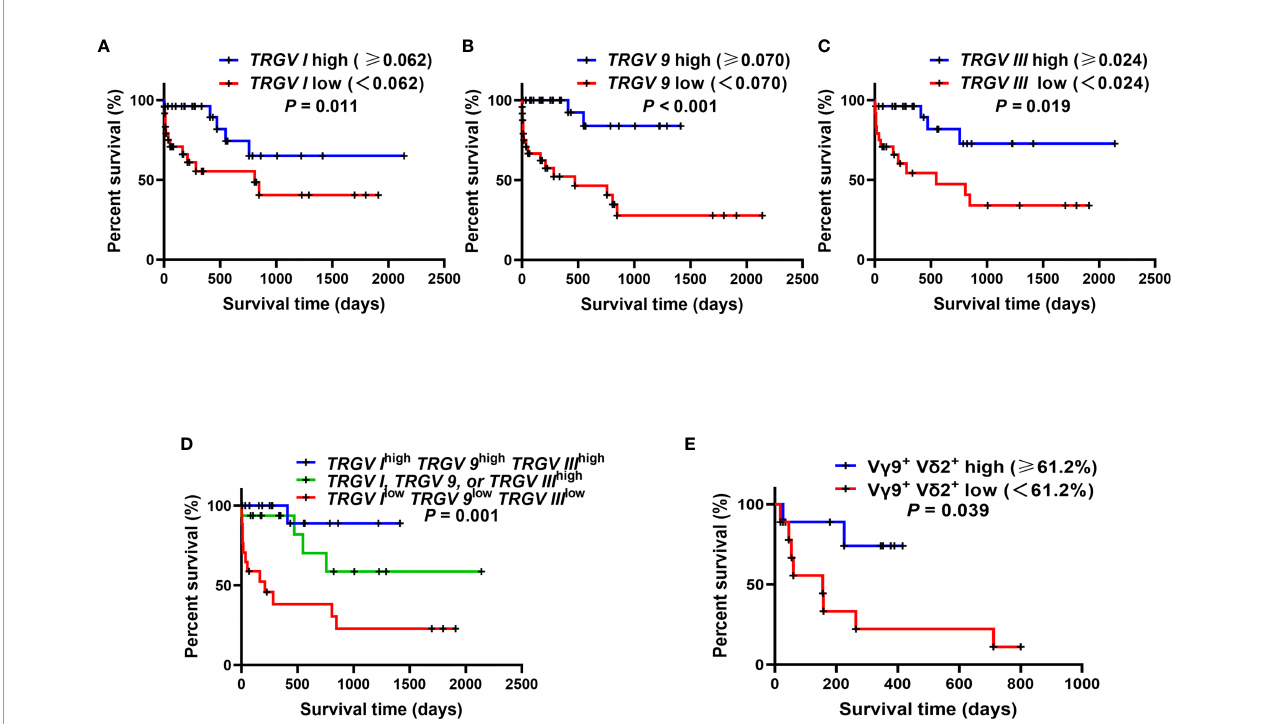
FIGURE 5 | Overall survival (OS) analysis of the gene expression levels of three TRGV subfamilies in 50 AML patients and the percentages of V g 9 + V d 2 + T cells in 18 AML patients. Kaplan – Meier curves showed the OS for the high (blue line) and low (red line) TRGV expression groups (A – C) . Kaplan – Meier curves showed the OS for the co-high expression (blue line), single high expression (green line), and co-low expression (red line) of TRGV I , TRGV 9 and TRGV III (D) . Kaplan – Meier curves showed the OS for the high (blue line) and low (red line) percentages of V g 9 + V d 2 + T cells (E)